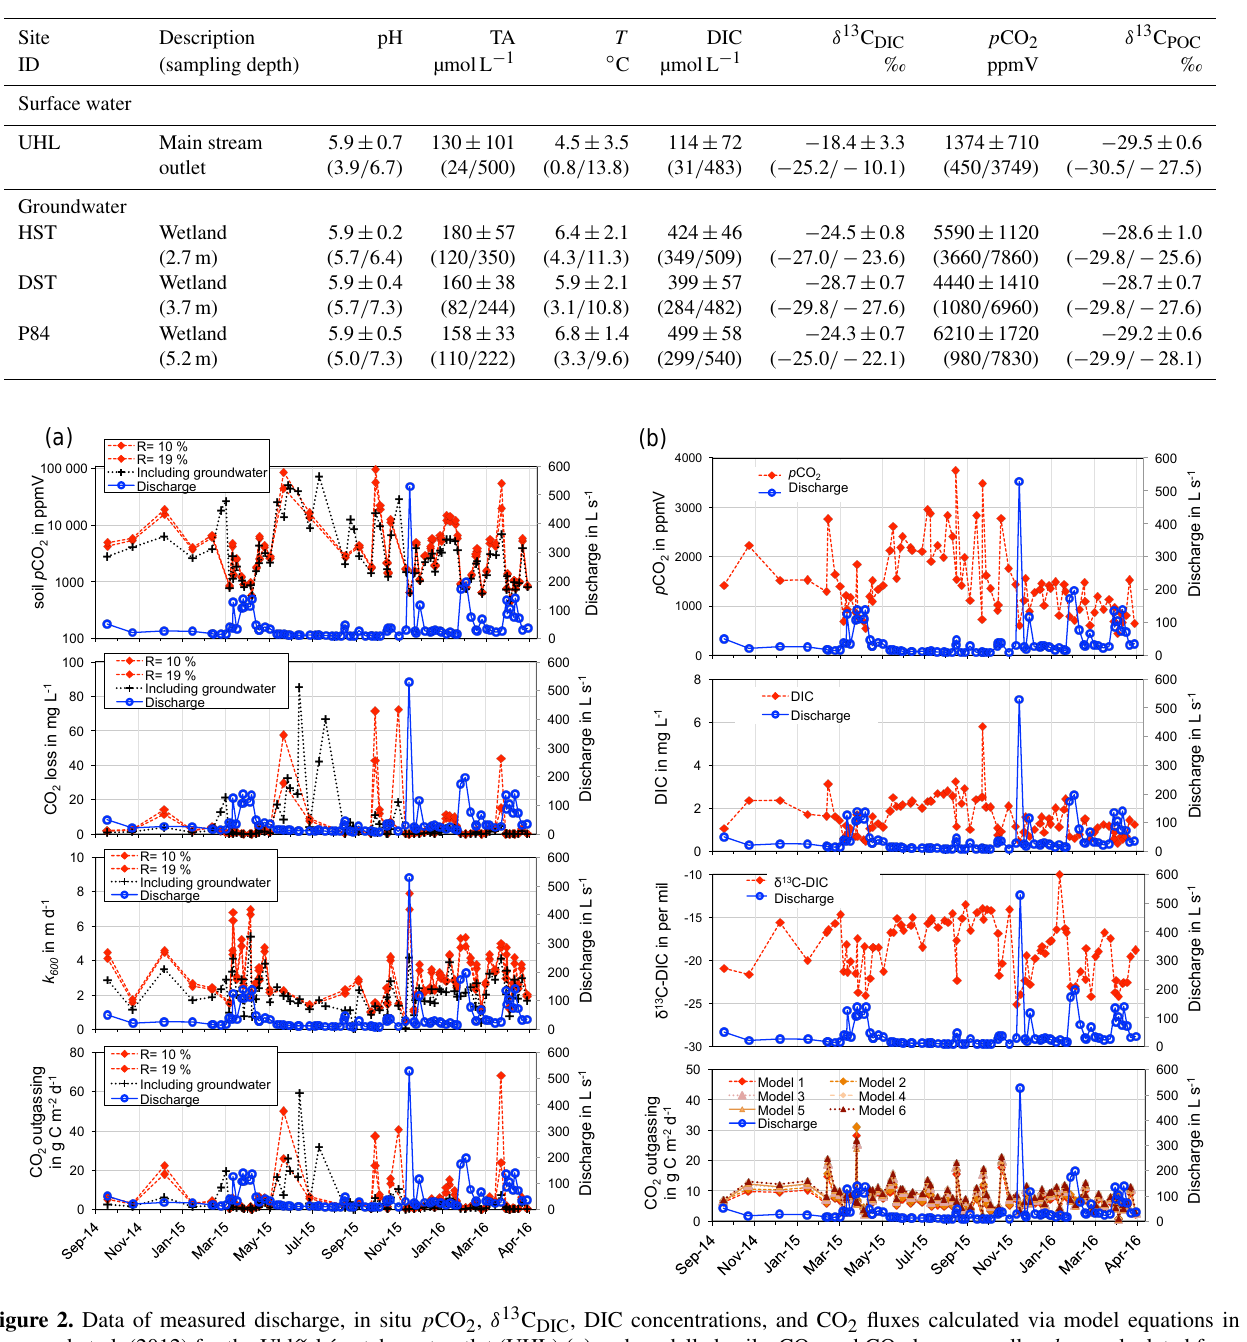
Table 2. pH, total alkalinity (TA), temperature ( T ), p CO 2 values, DIC concentrations and 13 C / 12 C ratios expressed as median values with ± 1 σ standard deviation and ranges given in parentheses. Site names are according to Fig. 1.